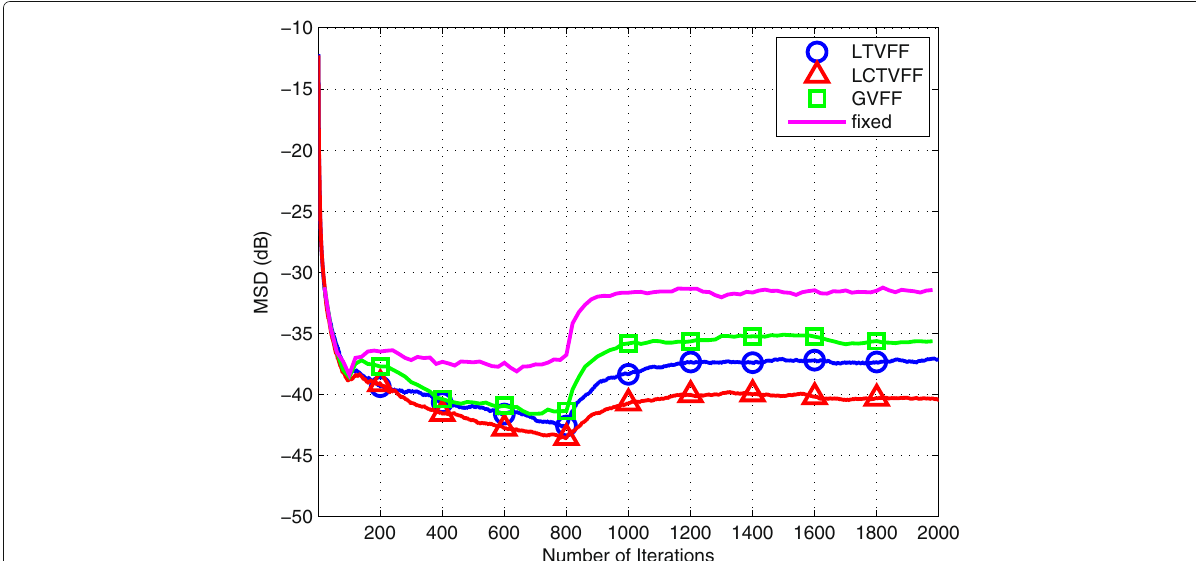
Fig. 14 MSD performance against number of iterations for the proposed and existing algorithms in a nonstationary environment